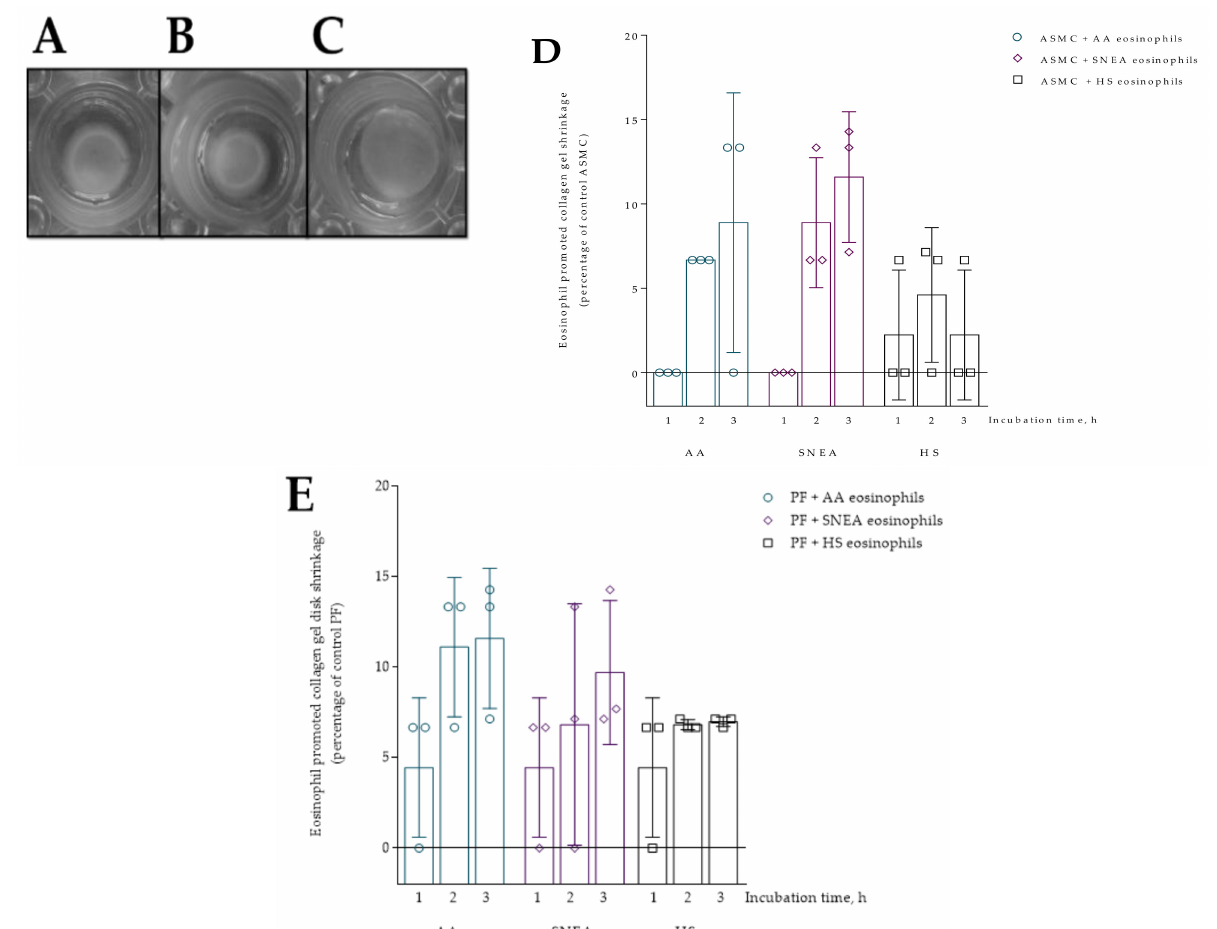
Figure 3. Collagen gel assay. ( A )—ASMC after 24 h incubation with HS eosinophils; ( B )—ASMC after 24 h incubation with SNEA patients’ eosinophils; ( C )—ASMC after 24 h incubation with AA patients’ eosinophils; ( D )—collagen gel contraction percentage from control ASMC after 1, 2, and 3 h incubation with subjects’ eosinophils, AA n = 3, SNEA n = 3, HS n = 3; ( E )—collagen gel contraction percentage from control PF cells after 1, 2, and 3 h incubation with subjects’ eosinophils, AA n = 3, SNEA n = 3, HS n = 3. AA—allergic asthma patient; ASMC—airway smooth muscle cells; HS— healthy subject; PF—pulmonary fibroblast; SNEA—severe non-allergic eosinophilic asthma patients. Data presented as mean ±